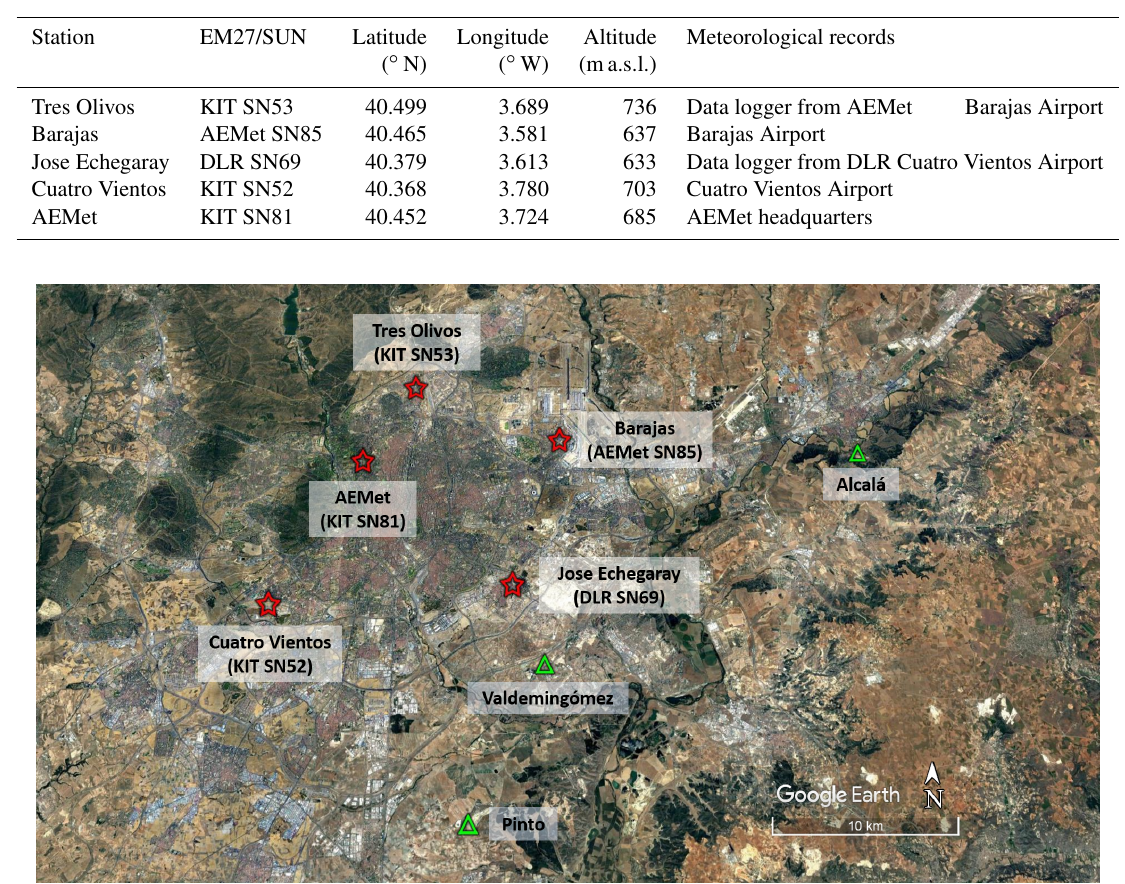
Figure 1. Locations of the five COCCON instruments used in the Madrid field campaign during 24 September–7 October 2018, represented with red stars, and locations of three waste treatment and disposal plants, represented with the green triangles (image © Google